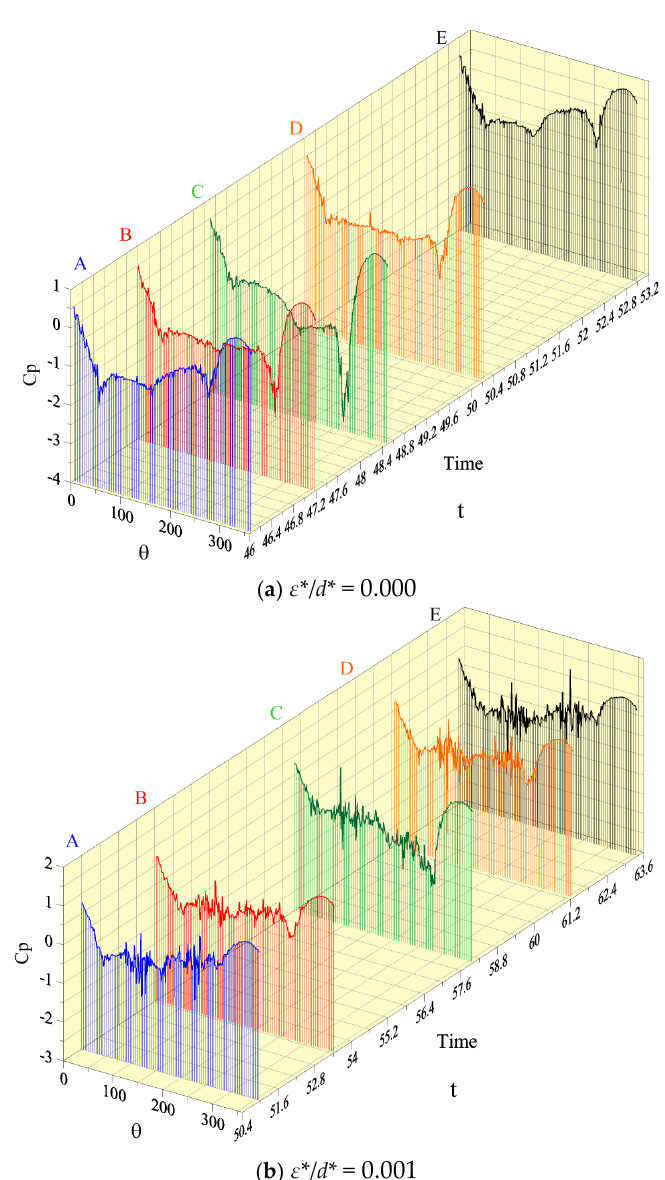
Figure 9. Instantaneous pressure distributions for the circular cylinder in the vicinity of a moving wall at h */ d * = 0.05; Re = 1.0 × 10 5 .